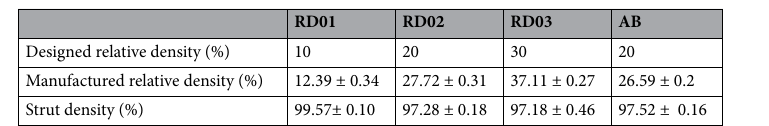
Table 1. Designed and manufactured relative densities.